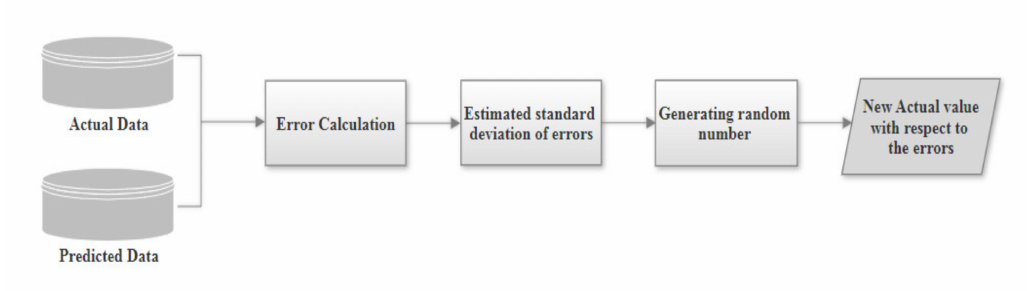
Figure 3. Noise generation process.